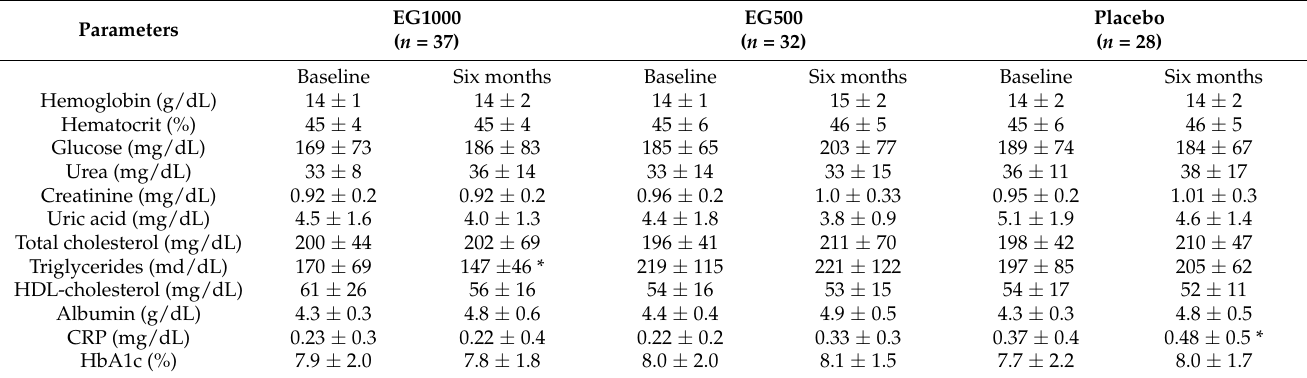
Table 2. Biochemical parameters of the study groups at baseline and after six